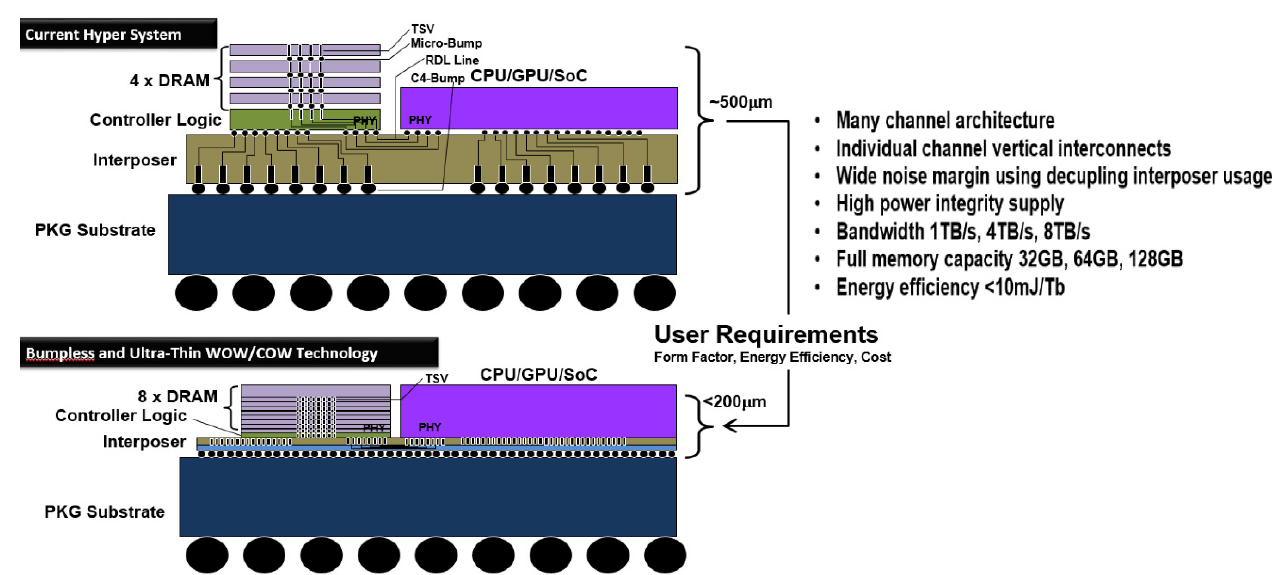
Figure 36. A comparison of conventional DRAM stack such as HBM and BBCube memory for 2.5D system. Competitive 3D structure accompanied with lowering system height and large memory capacity is anticipated.